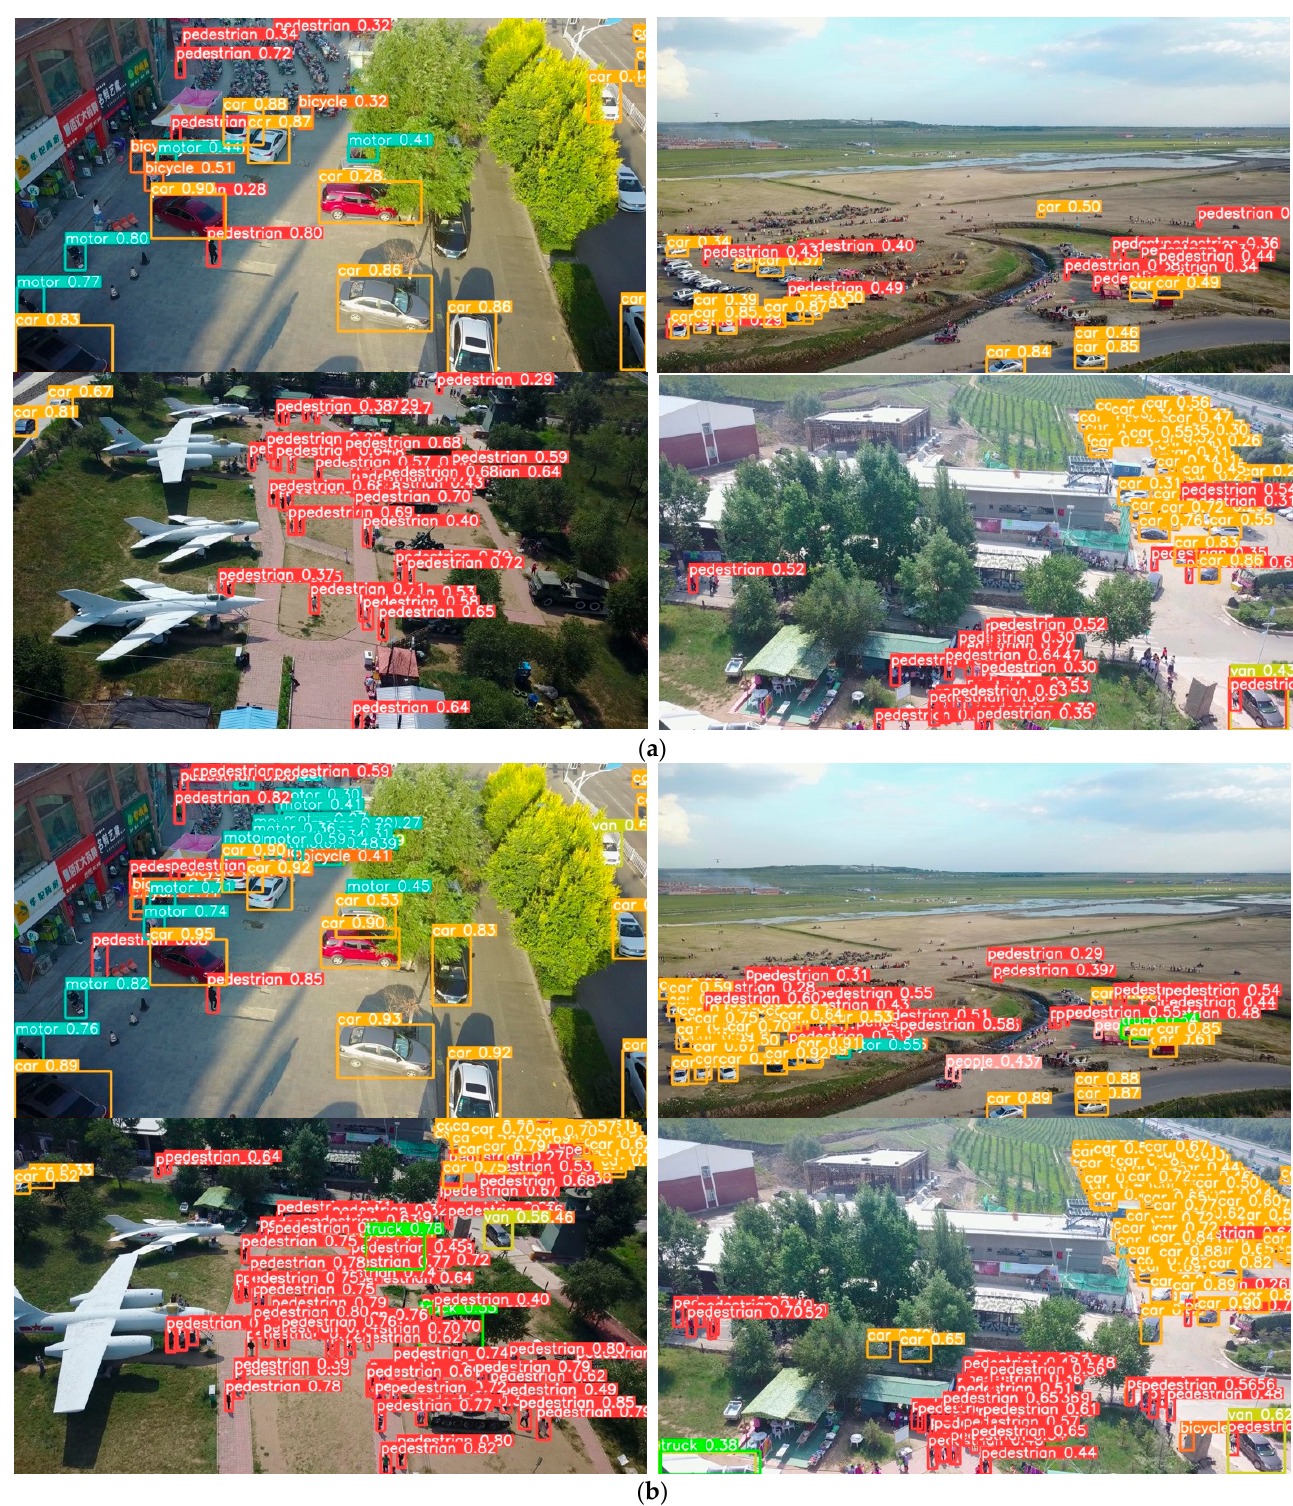
Figure 9. Test results comparison of the YOLOv5 algorithm: ( a ) The detection results of the original YOLOv5 algorithm; ( b ) The detection results of the proposed YOLOv5 algorithm.